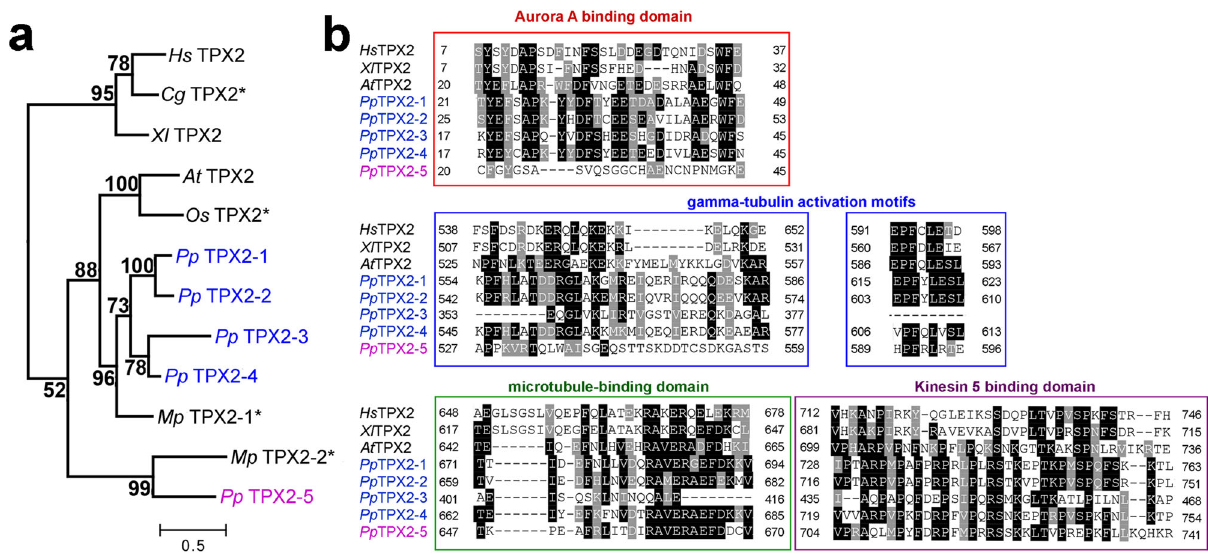
Fig. 1 TPX2 homologs in P. patens . a Phylogenetic analysis revealed two distinct groups of TPX2 proteins in P. patens : Pp TPX2-1 to − 4 (blue), which are more similar to TPX2 genes from seed plants, and atypical TPX2-5 (magenta). Asterisks mark predicted proteins, numbers show bootstrap values. Bar, 0.5 amino acid substitutions per site. Note that AtTPX2L3 and AtTPX2L2 were not added to this tree, since they lack the C-terminal region that is conserved in canonical TPX2 proteins. Hs: Homo sapiens , Gg: Gallus gallus , Xl: Xenopus laevis , At: Arabidopsis thaliana , Os: Oryza sativa , Pp: Physcomitrium patens , Mp: Marchantia polymorpha . b Alignment of TPX2 proteins. Conserved residues are boxed, whereas similar amino acids are